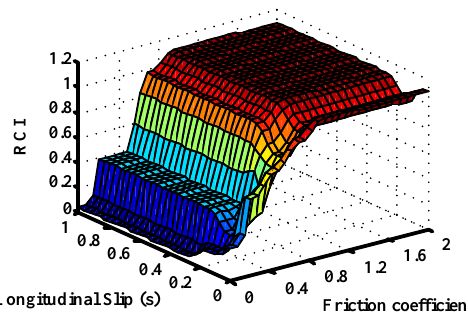
Figure 8. Output surfaces of the Fuzzy Road condition estimation block without dμ/ds.